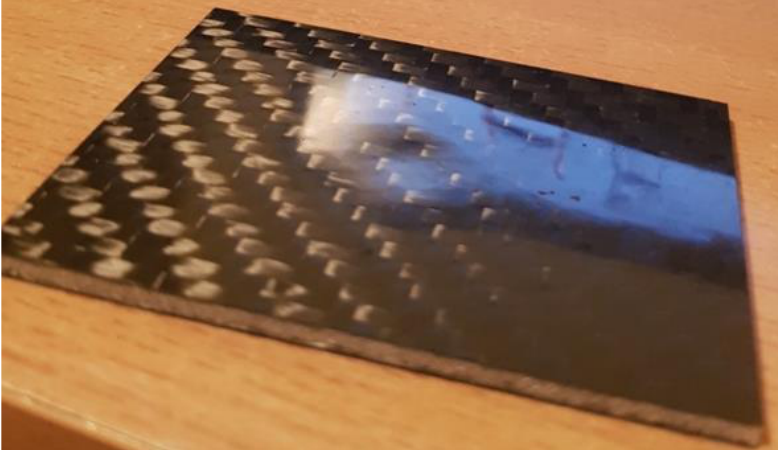
Figure 6. Average indentation depths of all tested composites.